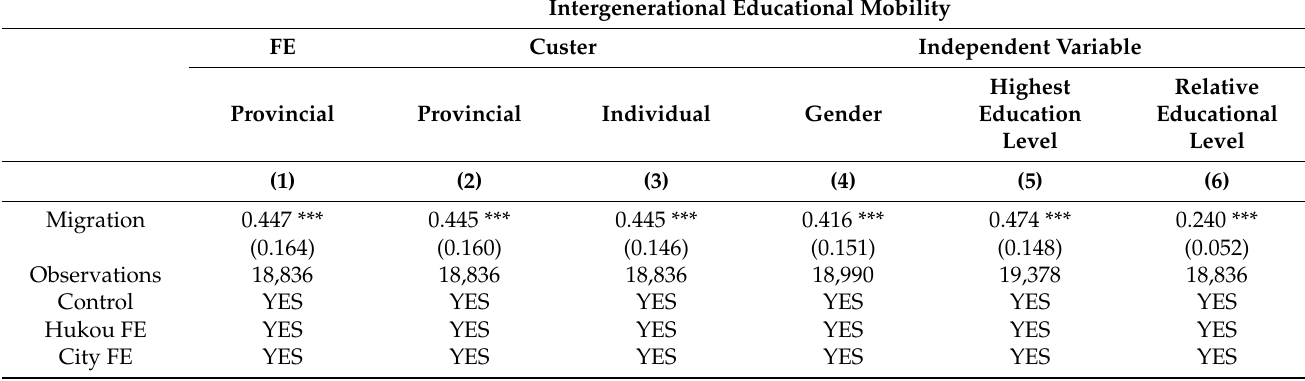
Table 6. Robustness checks.